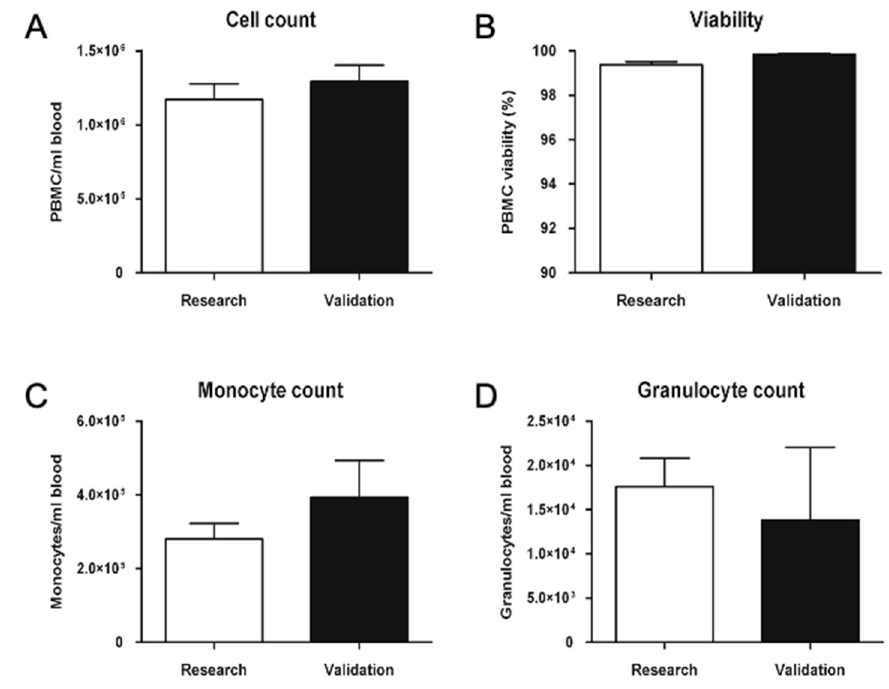
Figure 6. Validation of PBMC isolation in a GMP-compliant aseptic environment (clean room). Average cell count ( A ), viability ( B ), monocyte ( C ) and granulocyte ( D ) count of PBMC isolated from peripheral blood. Data are represented as mean ± SEM. Research N = 11, Validation N = 3.